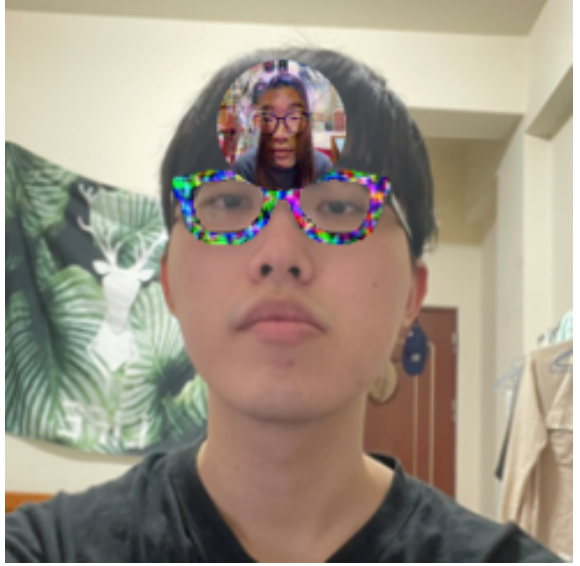
Figure 7. Addition of adversarial faces to face images with adversarial glasses in the digital world.